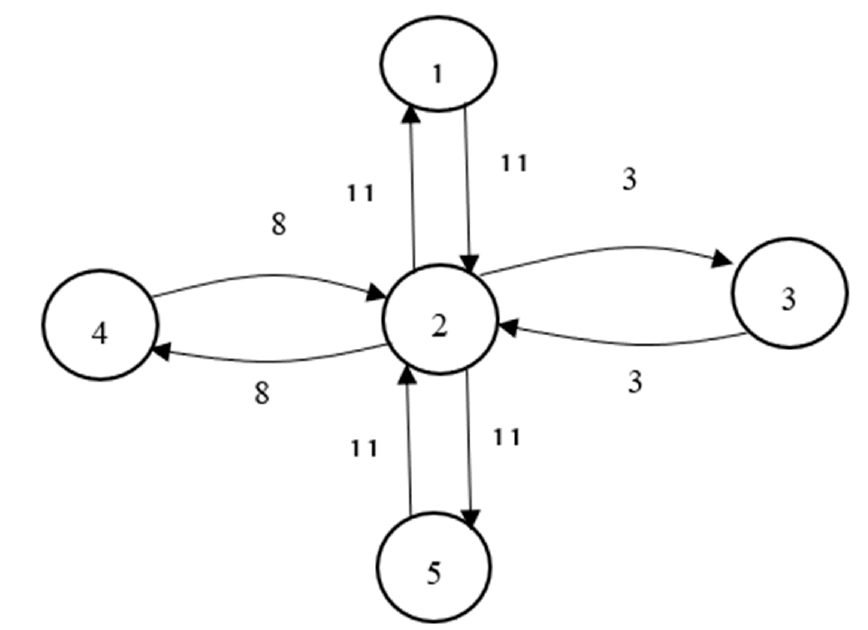
Figure 8. Equivalent bidirectional graph of a semidirected graph (Figure 6).